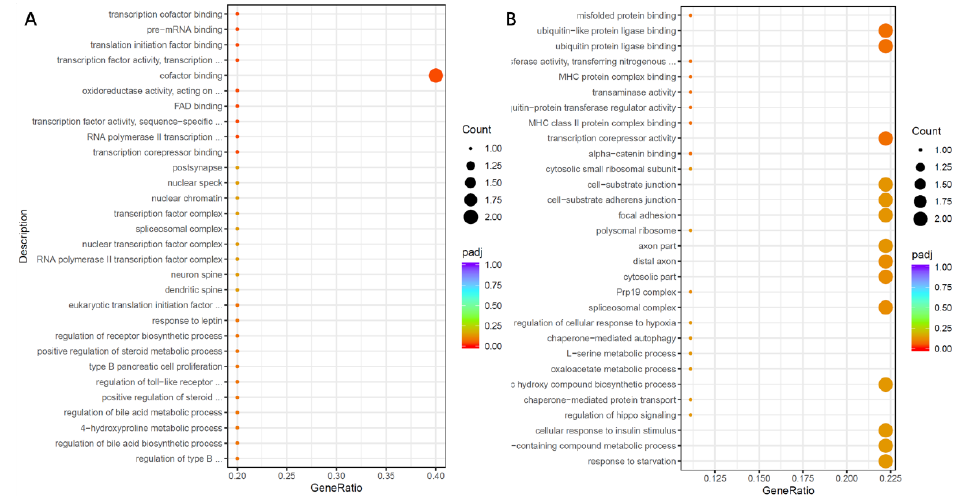
Figure 9. Effect of 2′ -FL on the signaling pathways of Klebsiella pneumoniae ( A ) and Clostridium perfringens ( B ) after organoid infection.